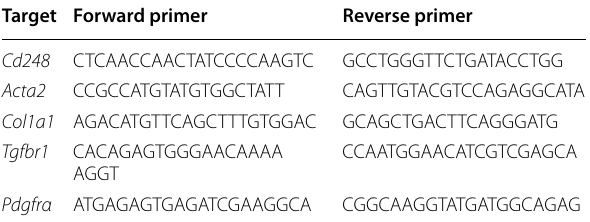
Table 1 Primers used for qRT‑PCR analysis